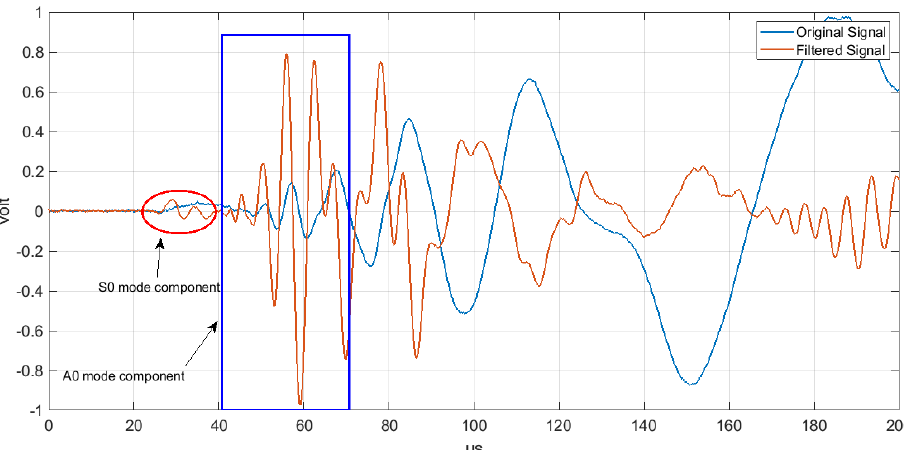
Figure 5. Comparison between original signal and filtered signal with high-pass second-order filter, with cut-off frequency 270 kHz followed by a 25-dB gain amplifier (see Figure 4). The signals were normalized and the distance between the impact point and the sensor was 10 cm. The two ultrasonic-guided modes A 0 (marked by blue box) and S 0 (marked by red oval) are well discriminated with high SNR.